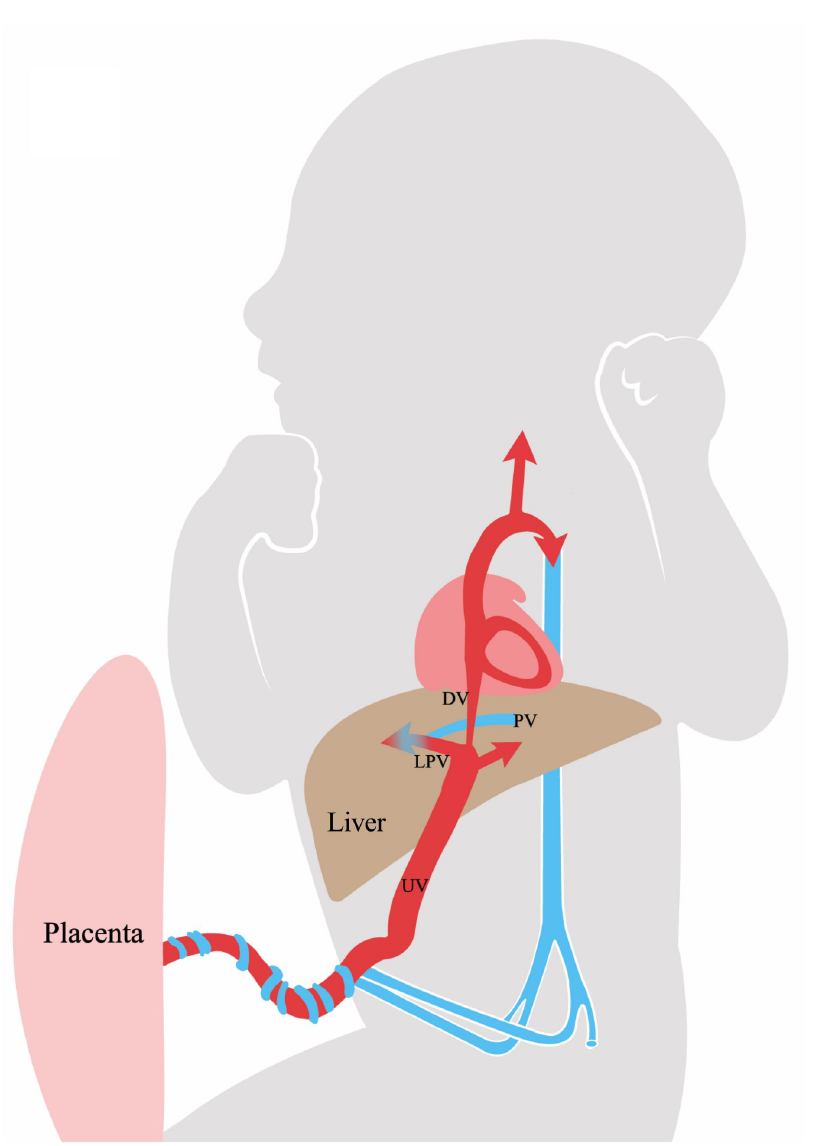
Fig 1. The fetal umbilical venous circulation schematic. Well-oxygenated and nutrient rich blood (red) from the placenta reaches the fetus through the umbilical vein (UV). This blood is distributed either to the fetal liver (arrows within the liver) or shunted through the ductus venosus (DV) to supply the heart and brain. The portal vein (PV) carries low-oxygenated blood (blue) from the visceral organs and blends in with the umbilical blood from the left portal branch (LPV) to supply the right liver